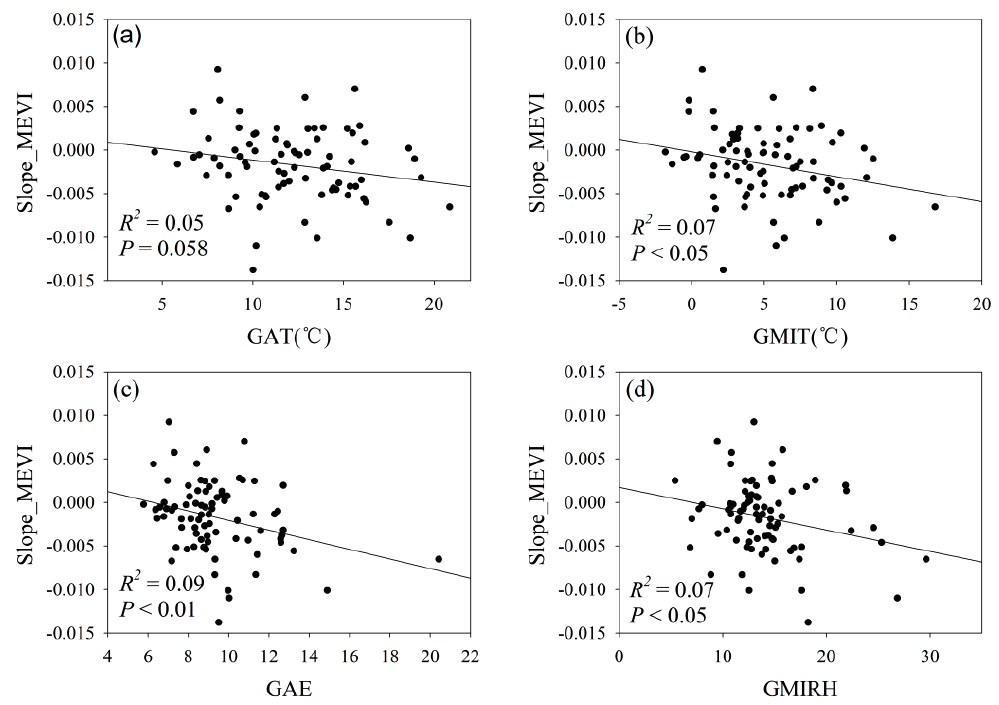
Figure 6. Relationships between several factors: ( a ) the linear trend for the growing season maximum enhanced vegetation index (Slope_MEVI) and growing season average temperature (GAT); ( b ) Slope_MEVI and growing season minimum temperature (GMIT); ( c ) Slope_MEVI and growing season average vapor pressure (GAE); and ( d ) Slope_MEVI and growing season minimum relative humidity